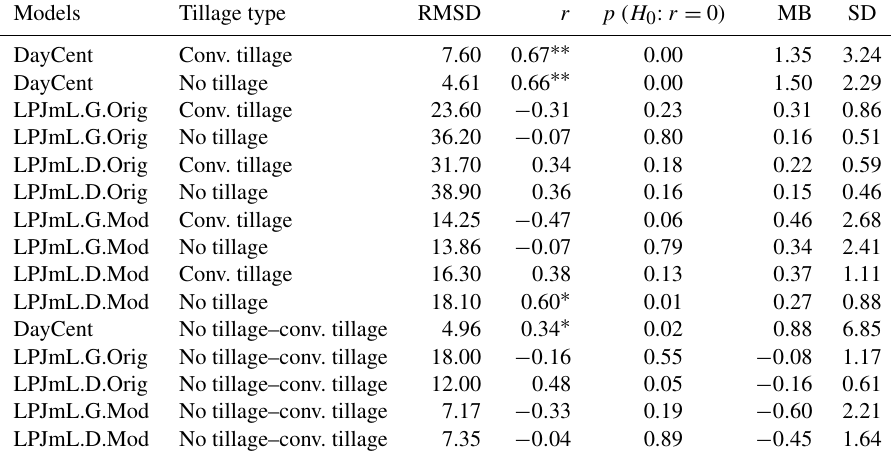
Significance levels are indicated with ∗ for p < 0 . 05 and ∗∗ for p < 0 . 01 for all r